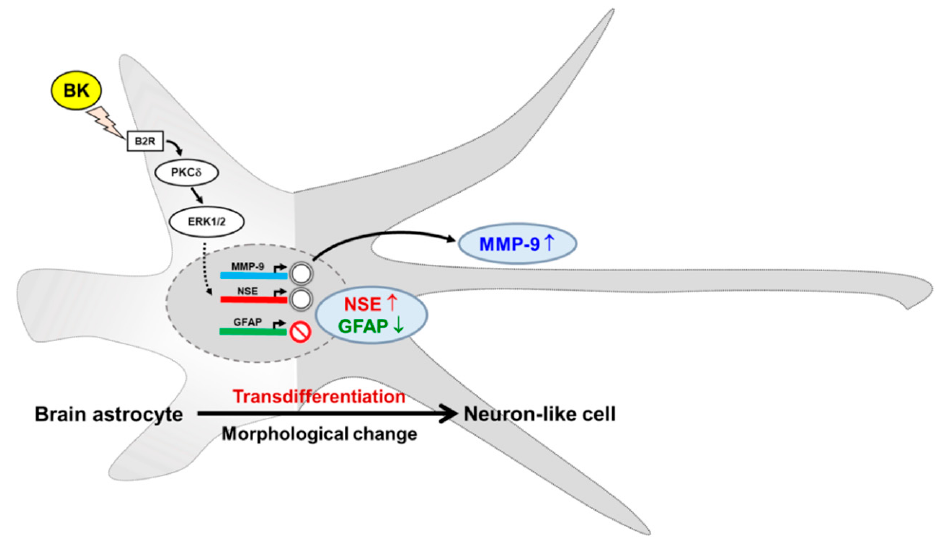
Figure 7. Schematic illustration of the BK-induced signaling pathways linked to reprogram RBA cells into neuron-like cells. Schematic representation of signaling pathways involved in BK-mediated upregulation of MMP-9 and NSE, downregulation of GFAP, and induction of morphological change into neuron-like cells in RBA cells. The binding of BK to its receptor (B 2 BKR) results in the activation of PKC- δ and ERK1/2 cascades. These events of BK-induced RBA cell morphological change into neuron-like cells, including regulation of various proteins, which are mediated through the B 2 BKR/PKC- δ /ERK pathway. Moreover, the upregulation of MMP-9 is critical for BK-induced RBA cell neurite fiber outgrowth in this process.